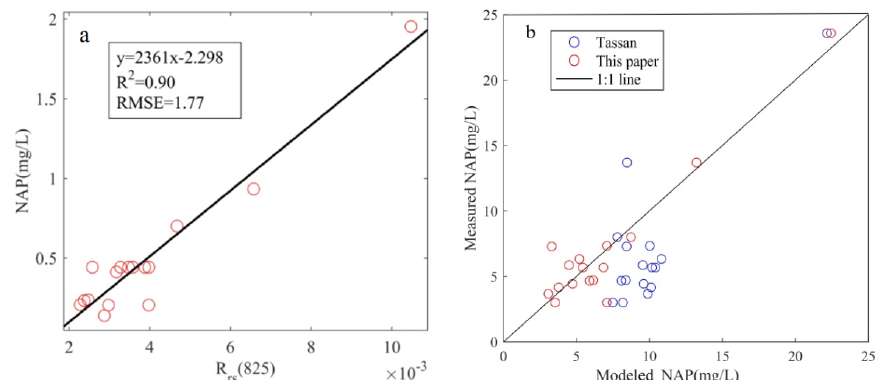
Figure A2. ( a ) Scatter plot of the estimated versus measured concentration of non-algal particles